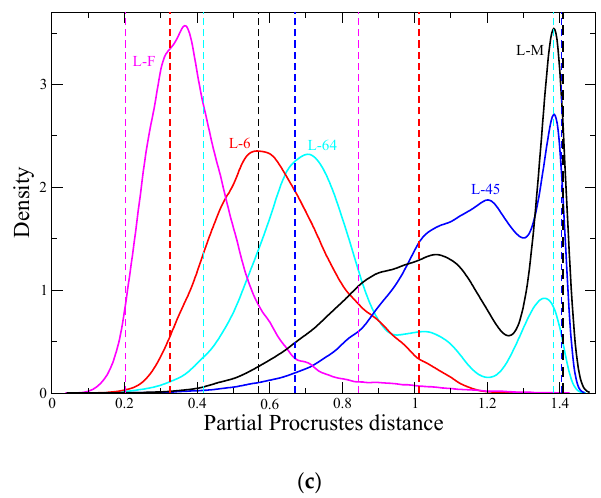
Figure 5. Best global product using Bootstrap validation processes via matrix distances: ( a ) Riemannian, ( b ) Full Procrustes, ( c ) Partial Procrustes. The functions represent the smoothing of the frequency histogram of the three distances. In all cases, the magenta color (L-F) distribution ratifies that the Fire CCI 5.0 product is very near to the reference data (LANDSAT images). This distribution has a leptokurtic behavior, and the mean is also closer to the zero value. The validation performances of the remaining products, under the three distances, are easily identified by the locus of the mean value and the confidence limits. Here L-6, L-64, L-45 and L-M, stand for the validation of MCD64C6, MCD64C5.1, MCD45 and Fire CCI 4.1, respectively. The last two products show a platykurtic behavior, with high tendency to dissimilarity (big biased to pi /